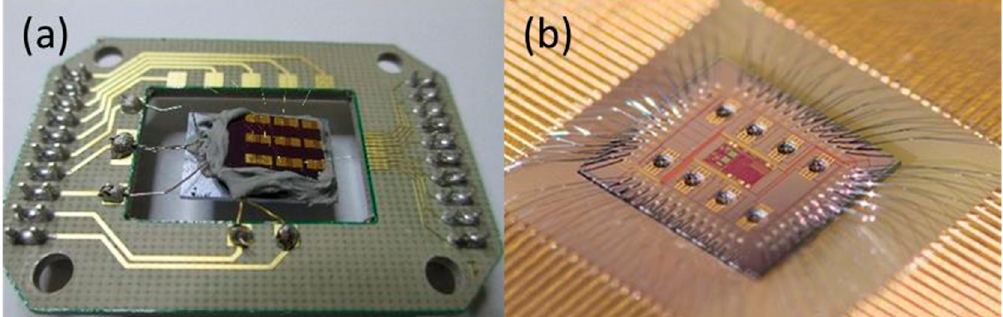
Figure 1. ( a ) Test chips on an external heater for MCL Box I setup. Wire bonds to a PCB electrically connect the sensors. They are mounted using thermo-conducive paste on a heating element with dimension of about 10 × 20 mm 2 . ( b ) CMOS integrated micro hotplate chip, heated area 70 × 70 µm 2 . This chip is also bonded by wire bonds to a PCB.